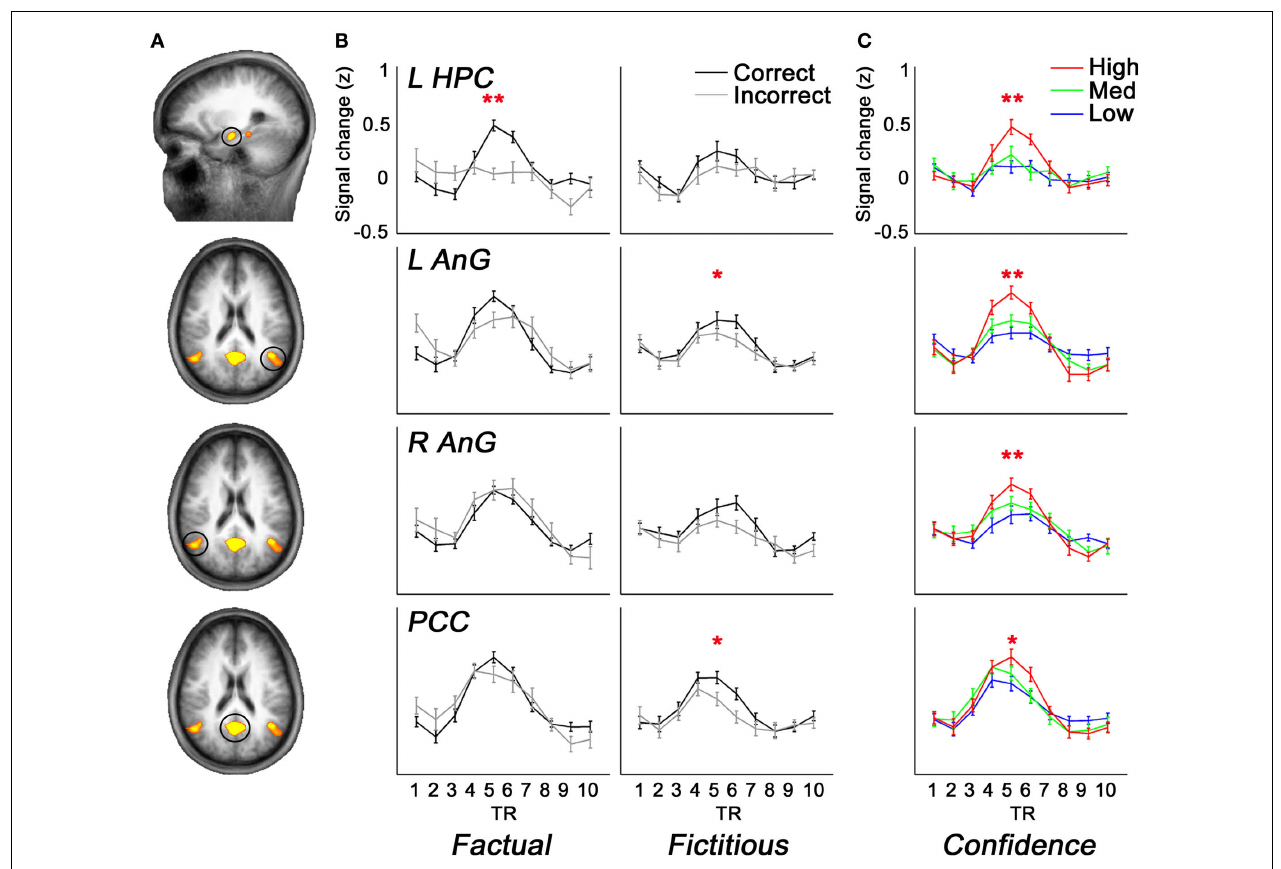
Activations are signifi cantly higher for Fact_cor vs. Fact_incor in left hippocampal complex, and for Fict_cor vs. Fict_incor in left angular gyrus and in posterior cingulate cortex/precuneus. (C) Average z-scores of BOLD response over time for the regions circled in (A) , calculated for high, medium, and low confi dence ratings. In all four regions, repeated-measures ANOVA analyses revealed main effects for confi dence levels, indicating that as confi dence ratings increased, so did BOLD activations. L = left, R = right, HPC = hippocampal complex, AnG = angular gyrus, PCC = posterior cingulate cortex, * = p < 0.05, ** = p <